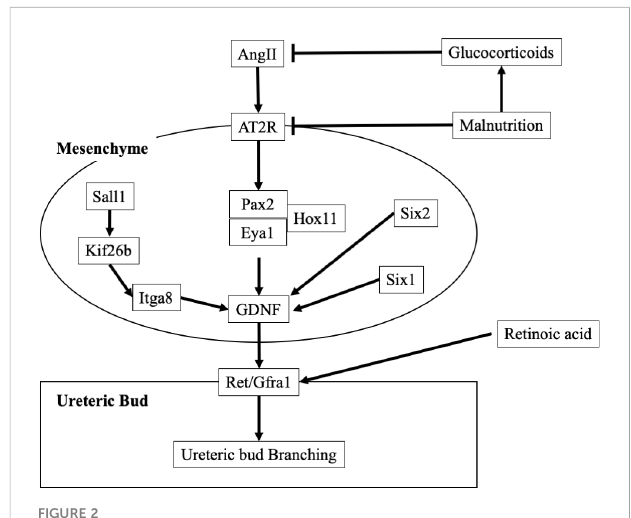
FIGURE 2 Molecular mechanisms of ureteric bud branching. AngII, Angiotensin II; AT2R, AngII type 2 receptor; Eya1, Eyes absent homolog 1; GDNF, Glial-cell-line-derived neurotrophic factor; Gfra1, GDNF family receptor a 1; Hox11, Hombox gene 11; Itga, Integrin subunit aplpha; Kif, kinesin superfamily proteins; Pax2, Paired box gene; Ret, ret proto- oncogene; Sall, sal-like; Six, Sine oculis-related homeobox.